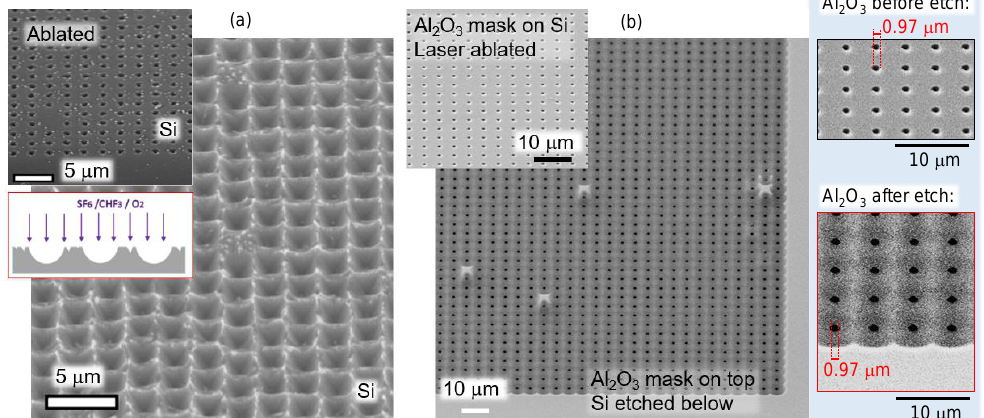
Figure 6. ( a ) Maskless patterning of Si with PhC light-trapping structures using fs laser ablation and dry plasma etching. Pulse energy E p ≈ 3.2 nJ (at focus), NA = 0.9. The inset shows just the ablated surface of the Si. ( b ) Si patterning by plasma etching using a 20 nm-thick Al 2 O 3 mask. E p = 4.2 nJ (at focus), NA = 0.9. Left: The insets show close-up views of the laser-ablated openings in the mask, which have a diameter ∼ 1 µ m for the 20 nm-thick Al 2 O 3 . The dry plasma etching conditions were the same as for the Al 2 O 3 mask with the bias set at 5 W (a directional etch